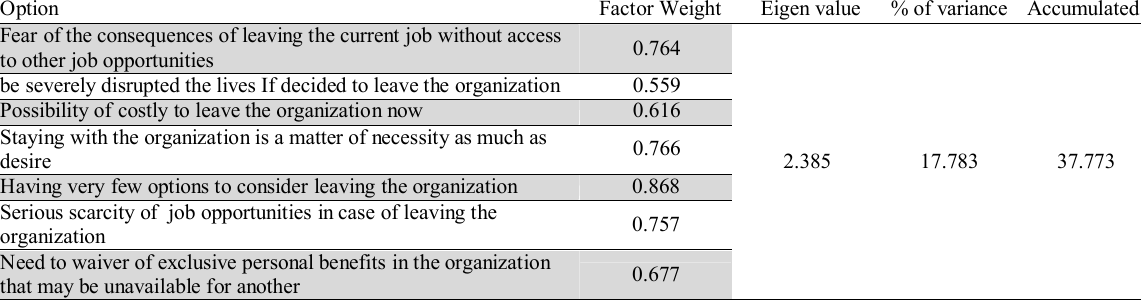
Details of factor analysis for Continuous commitment Option Factor Weight